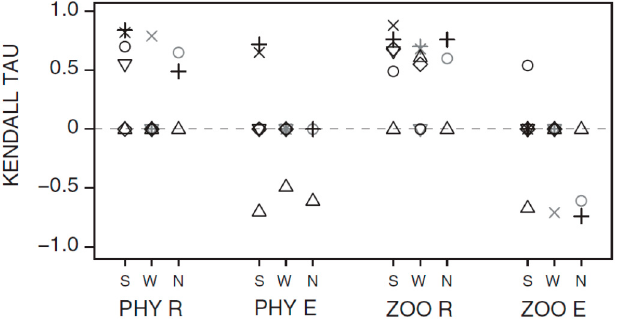
Figure 5. Summary of temporal change (Pearson’s correlation with years) in annual phyto ‐ and zooplankton assemblage richness and evenness in S, W and N lakes. See Figure 4 for details.